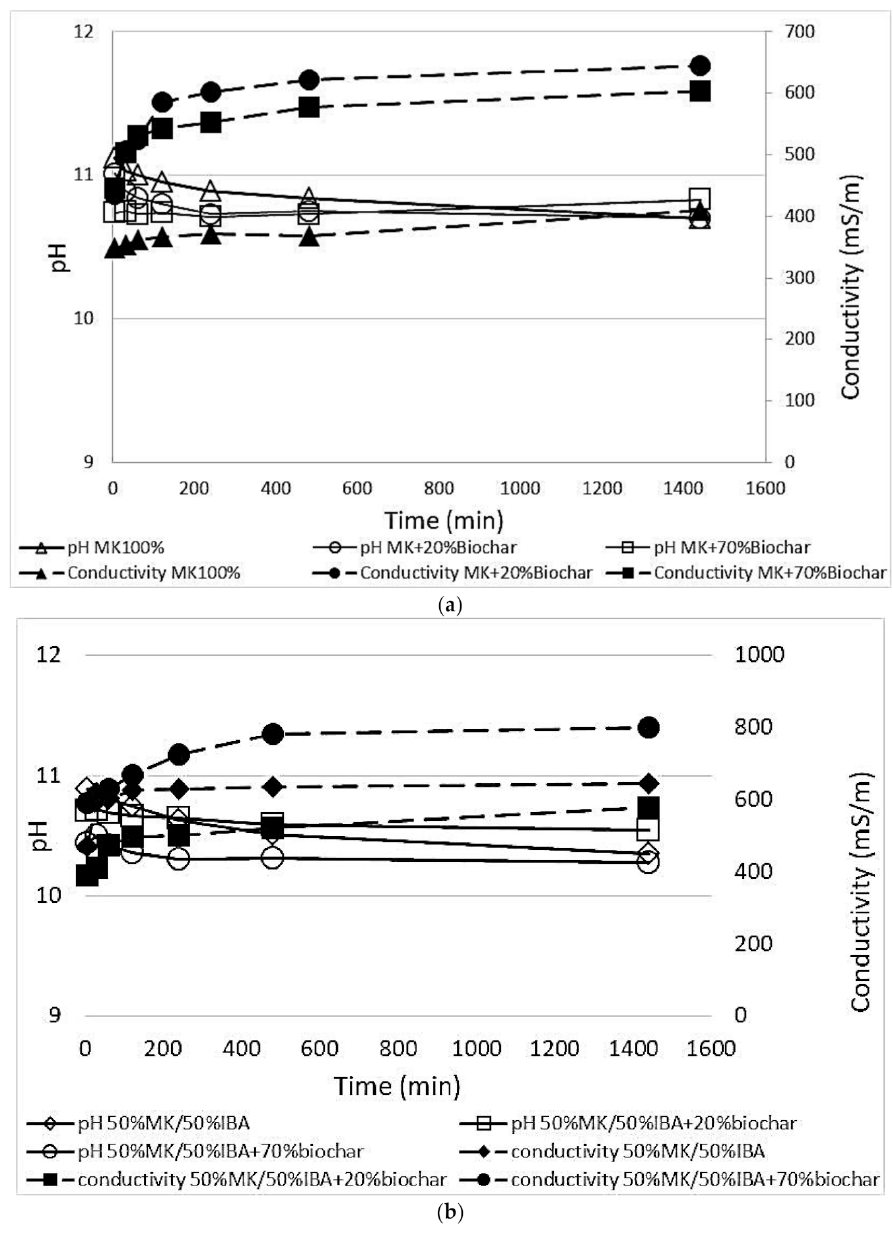
Figure 7. pH and conductivity trend of ( a ) first series samples and ( b ) second series samples at 90 days of